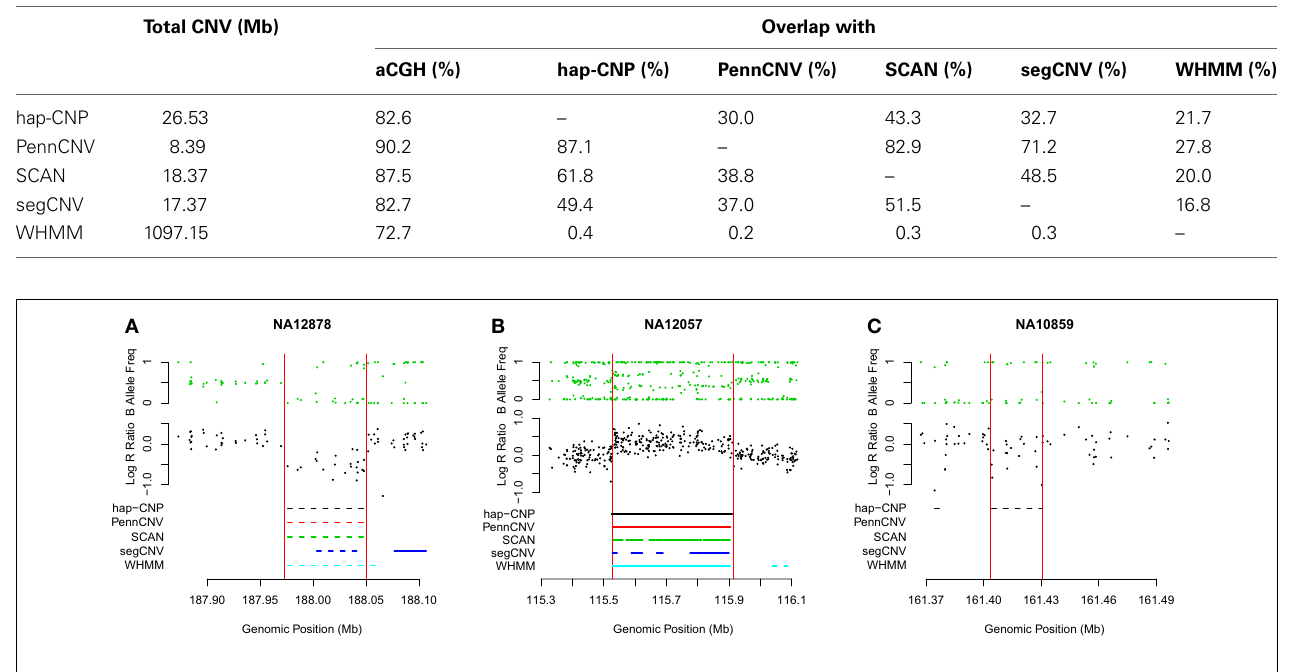
FIGURE 2 | Detected CNV intervals. Three regions from three different HapMap samples were taken to show the detected regions. (A,B) Show deleted and duplicated regions detected by all five methods. (C) Shows a deleted region only detected by our method. All regions are located in chromosome